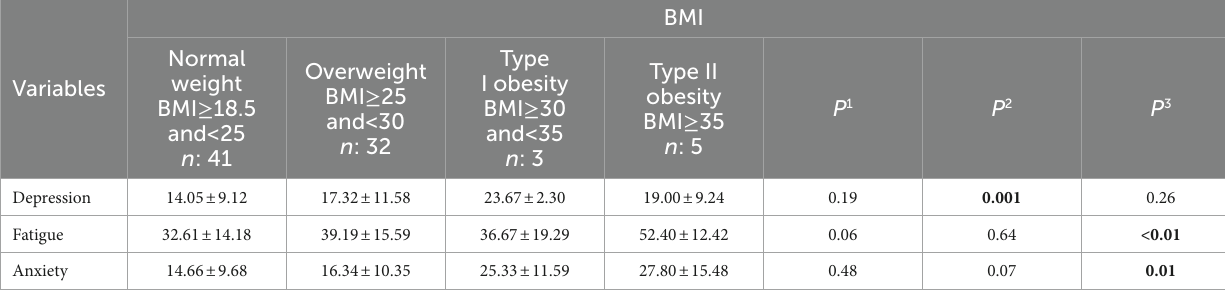
TABLE 4 The difference in fatigue, anxiety, and depression scores between BMI categories.